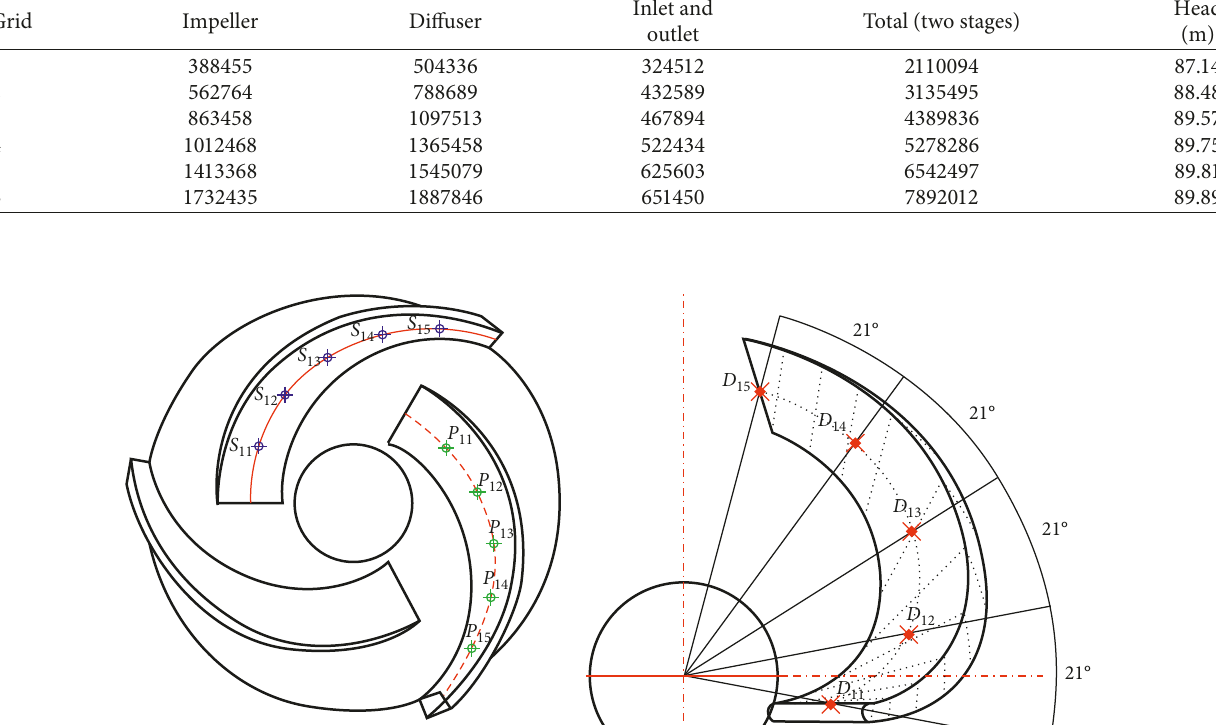
Table 2: Grid independence analysis ( Q